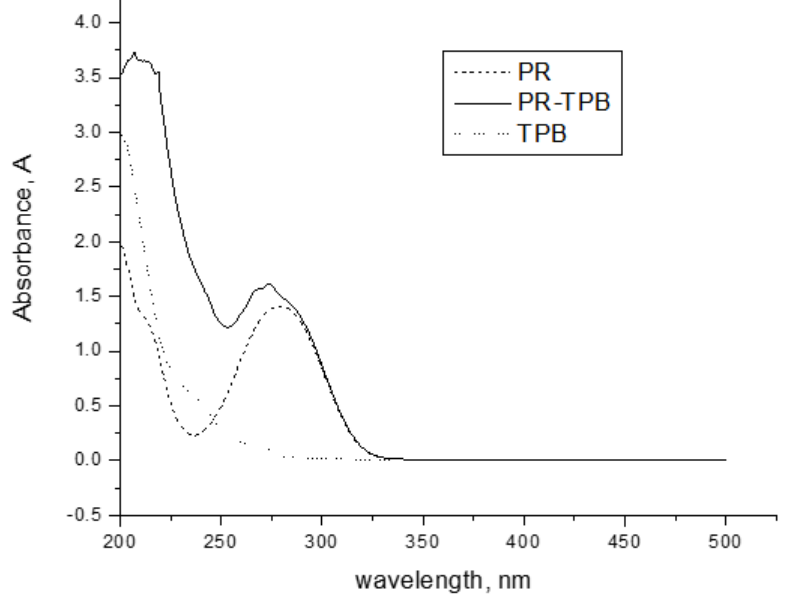
Figure 1. Absorption spectra of procainamide, sodium tetraphenyl borate, and procainamide- tetraphenyl borate (0.0001M, each).